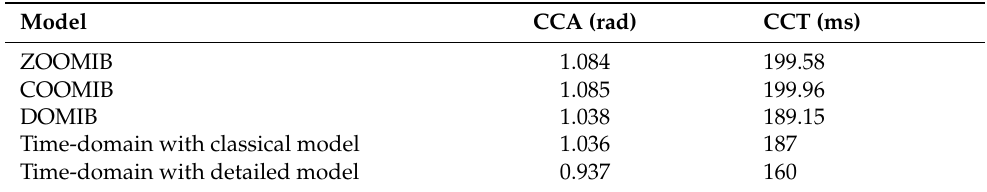
Figure 21. Comparison of the δ − P curves obtained with ZOOMIB and DOMIB models with time-domain simulations. Table 2. A comparison between time-domain simulation results with the results obtained with different OMIB equivalent assumptions and Taylor